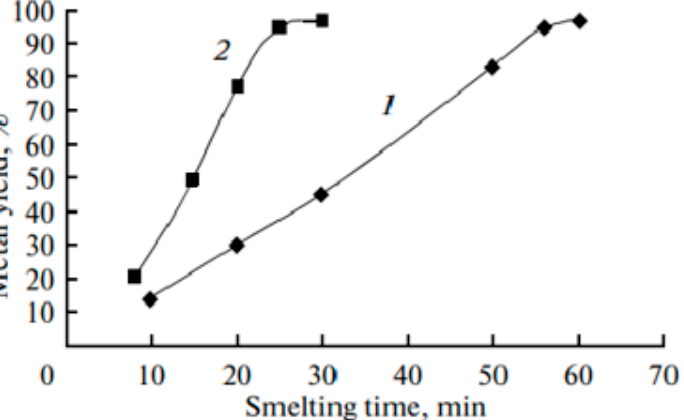
Figure 17. Dependence of the metal yield on the smelting time. ( 1 ) Without irradiation and ( 2 ) with irradiation [46].